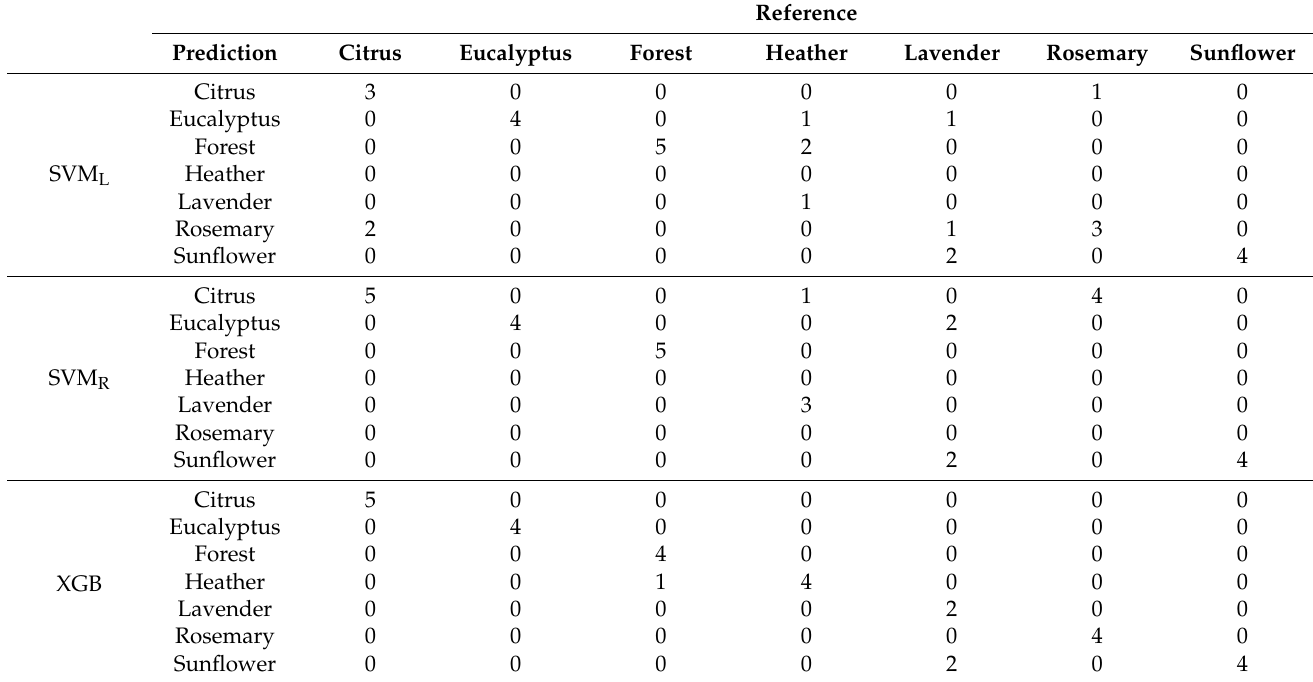
Table 4. Confusion matrices of various classifier algorithms (SVM L , SVN R and XGBoost) on the test set. The number of honey samples was the same as that indicated in Table 2.